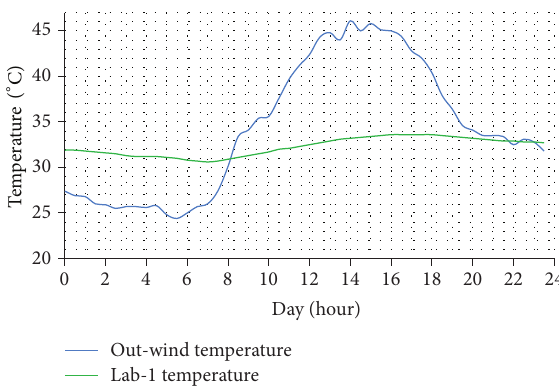
Figure 4: Overall hottest day. This was 7th April 2013 with a high temperature of 46.1 ∘ C. “Out-wind temperature” is the temperature of outside environment; “Lab-1” is the ambient temper- ature of Lab-1.